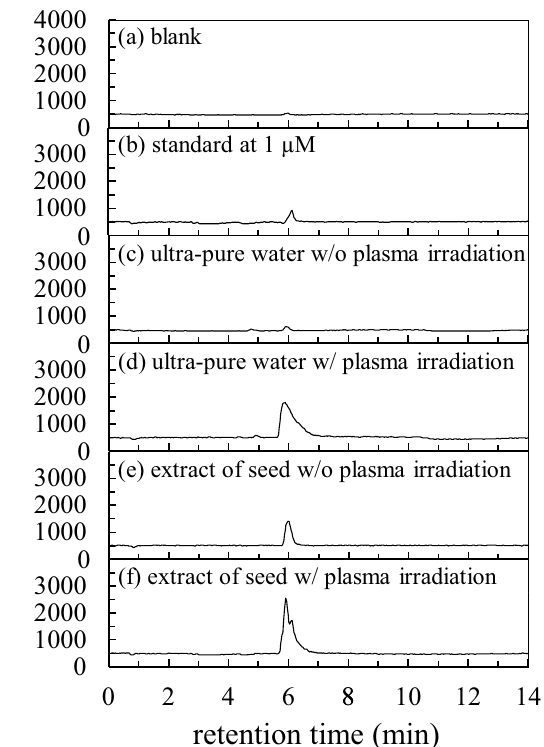
Figure 5. EIC of 62 m/z of ( a ) blank, ( b ) standard solution of NO 3 − at 1 µM of concentration, ultra-pure water ( c ) without plasma irradiation and ( d ) with plasma irradiation for 5 min, and extract of seed ( e ) without plasma irradiation and ( f ) with plasma irradiation for 5 min.